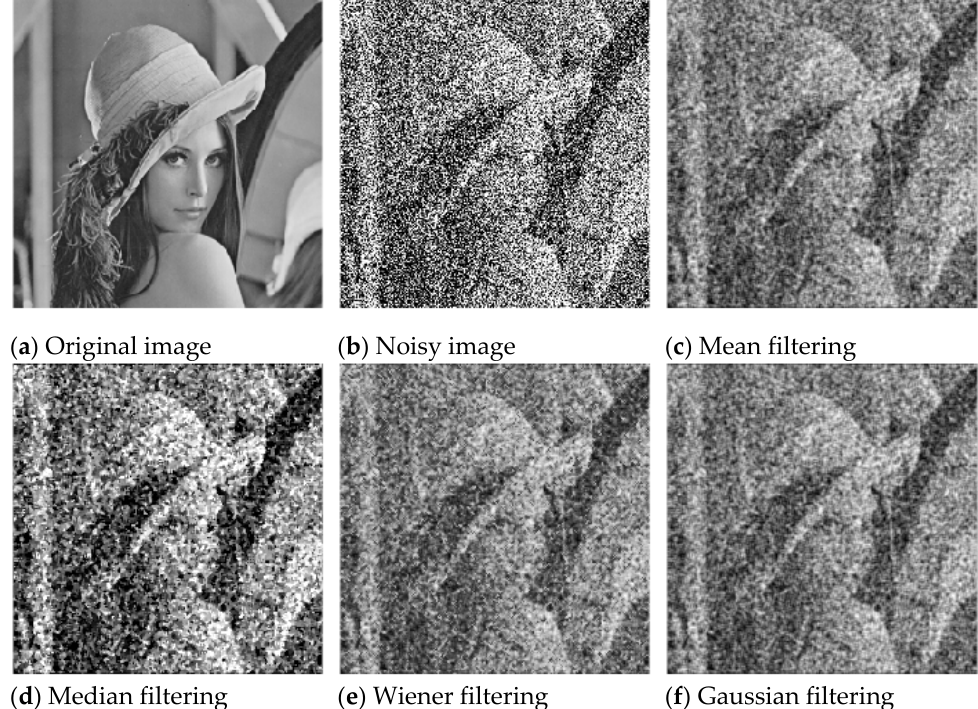
Figure 4. Lena image enhancement for four classical filtering methods.